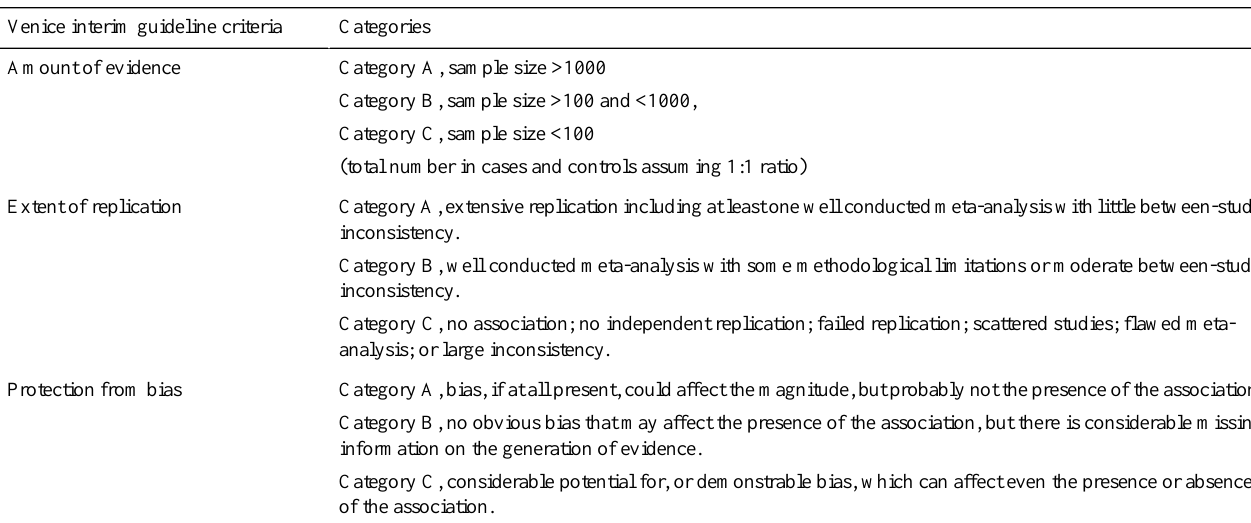
Table 1. Venice interim guideline criteria for assessment of cumulative evidence on genetic associations [47]. CategoriesVenice interim guideline